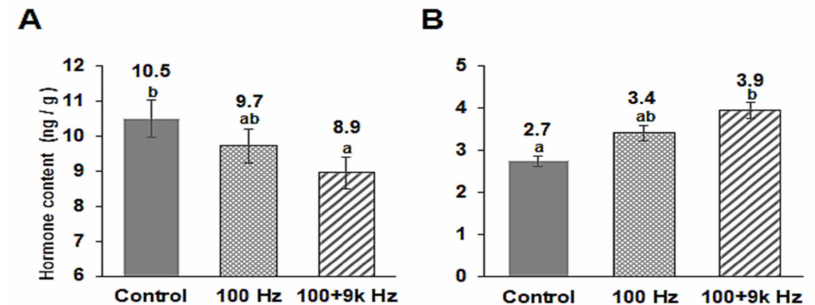
Figure 6. Analysis of plant growth hormone content in Arabidopsis roots after sound wave treatments. ( A ) Cytokinin zeatin content. ( B ) Auxin IAA content. Error bars indicate the standard error of three biological replicates. Different letters above the bars indicate significantly different mean values ( p < 0.05) based on Duncan’s multiple range test.